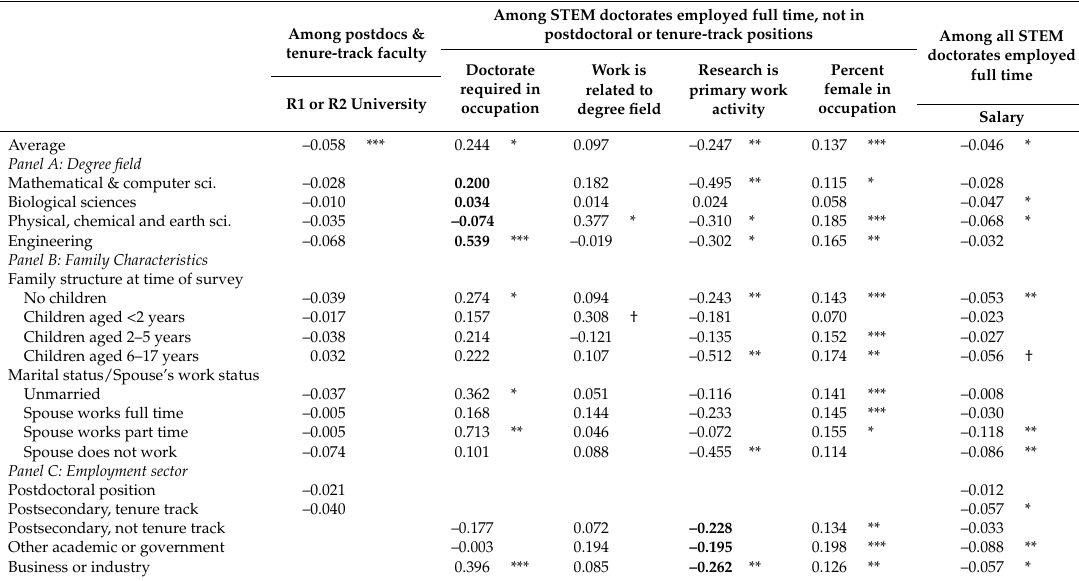
doctorates employed full timeDoctorate